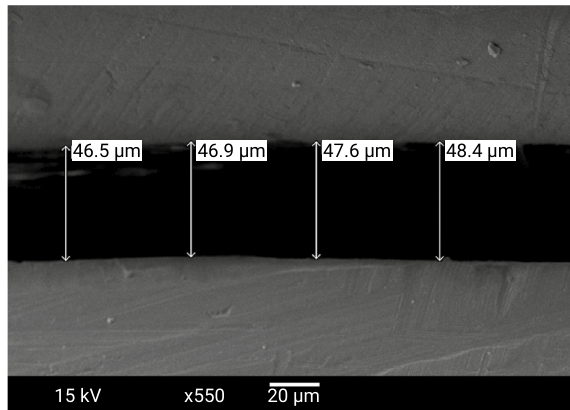
Figure 1. Measurement of the gap existing between the crown and the prosthetic abutment.